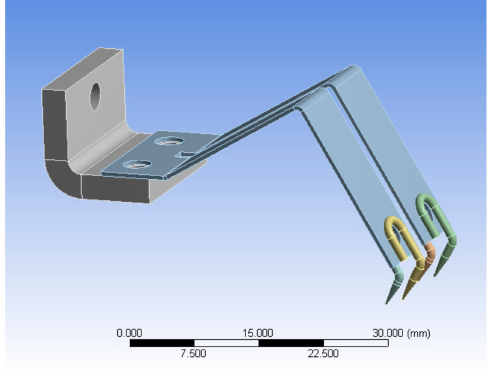
Figure 7. Simplified geometric model of the spiny